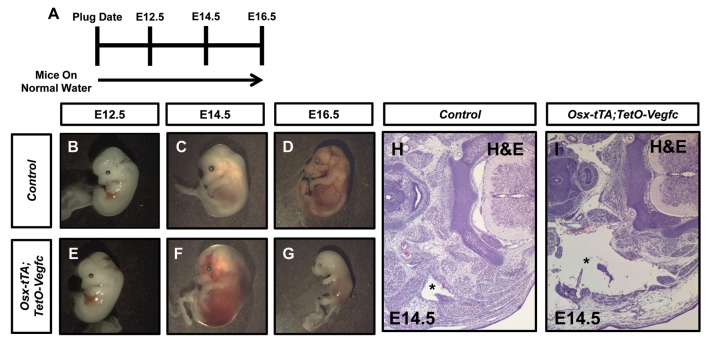
Expression of VEGF-C during embryonic development causes embryonic lethality.(A) Schematic showing when mice received normal water. (B–C) Representative images of E12.5, E14.5 and E16.5 control embryos. (E–G) Representative images of E12.5, E14.5 and E16.5 Osx-tTA;TetO-Vegfc embryos. (H,I) Transverse sections of E14.5 embryos stained with hematoxylin and eosin. The jugular lymph sac (asterisk) in the control embryo appears normal. In contrast, the jugular lymph sac (asterisk) in the Osx-tTA;TetO-Vegfc embryo is enlarged.